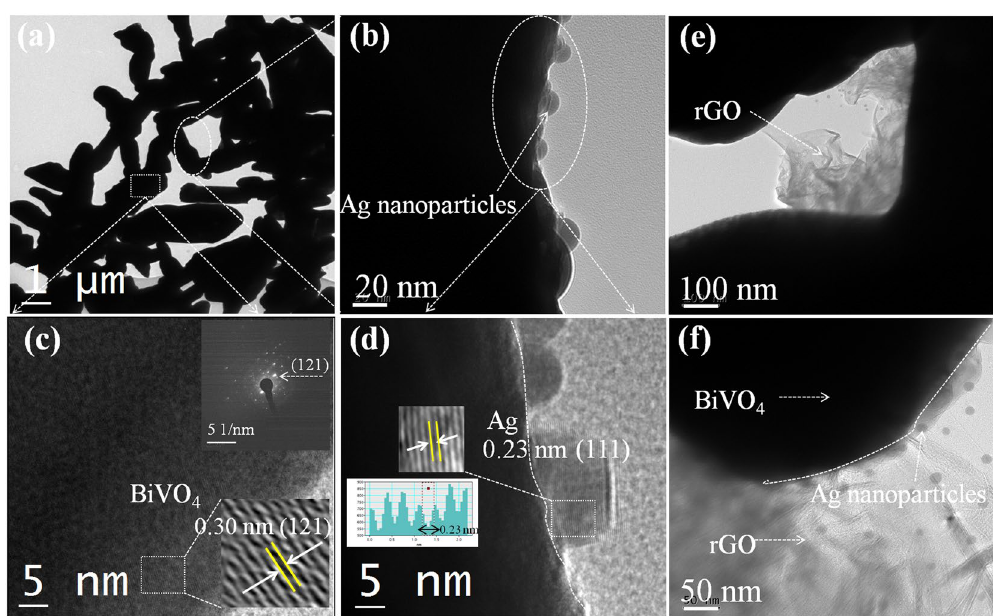
Figure 4. TEM and HRTEM images of ( a – d ) BiVO 4 /Ag2% hybrid sample (inset shows the SAED pattern) and ( e , f ) BiVO 4 /Ag2%/rGO hybrid